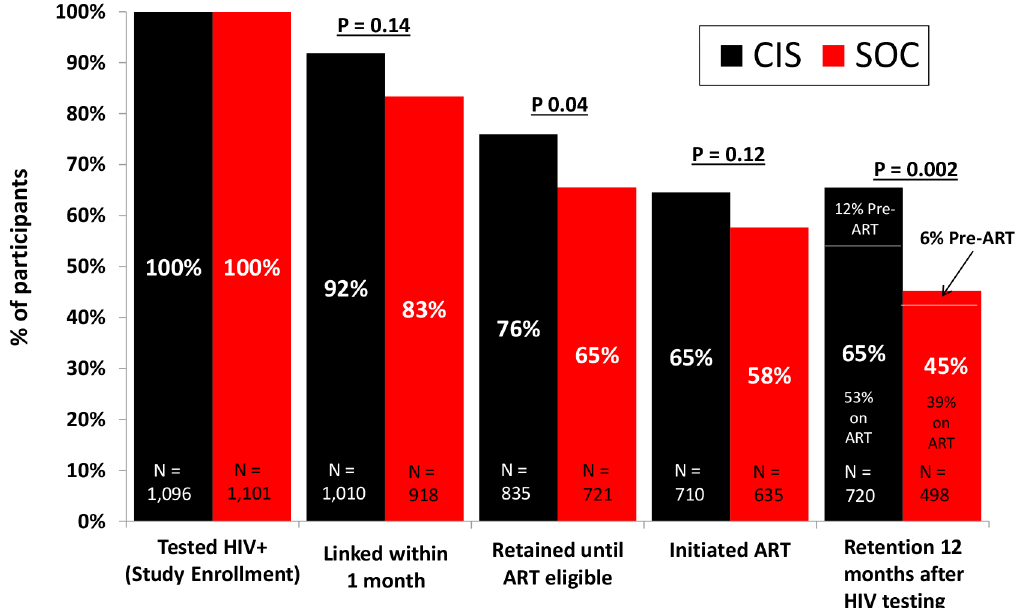
Fig 3. HIV care continuum comparing the combination intervention strategy(CIS) study arm versus the standard of care (SOC) study arm.